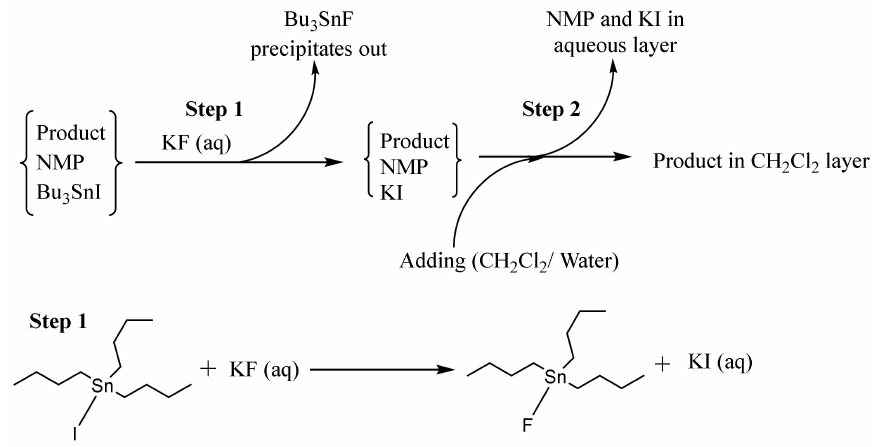
Scheme 4. Schematic drawing of the purification process of the Stille reaction product